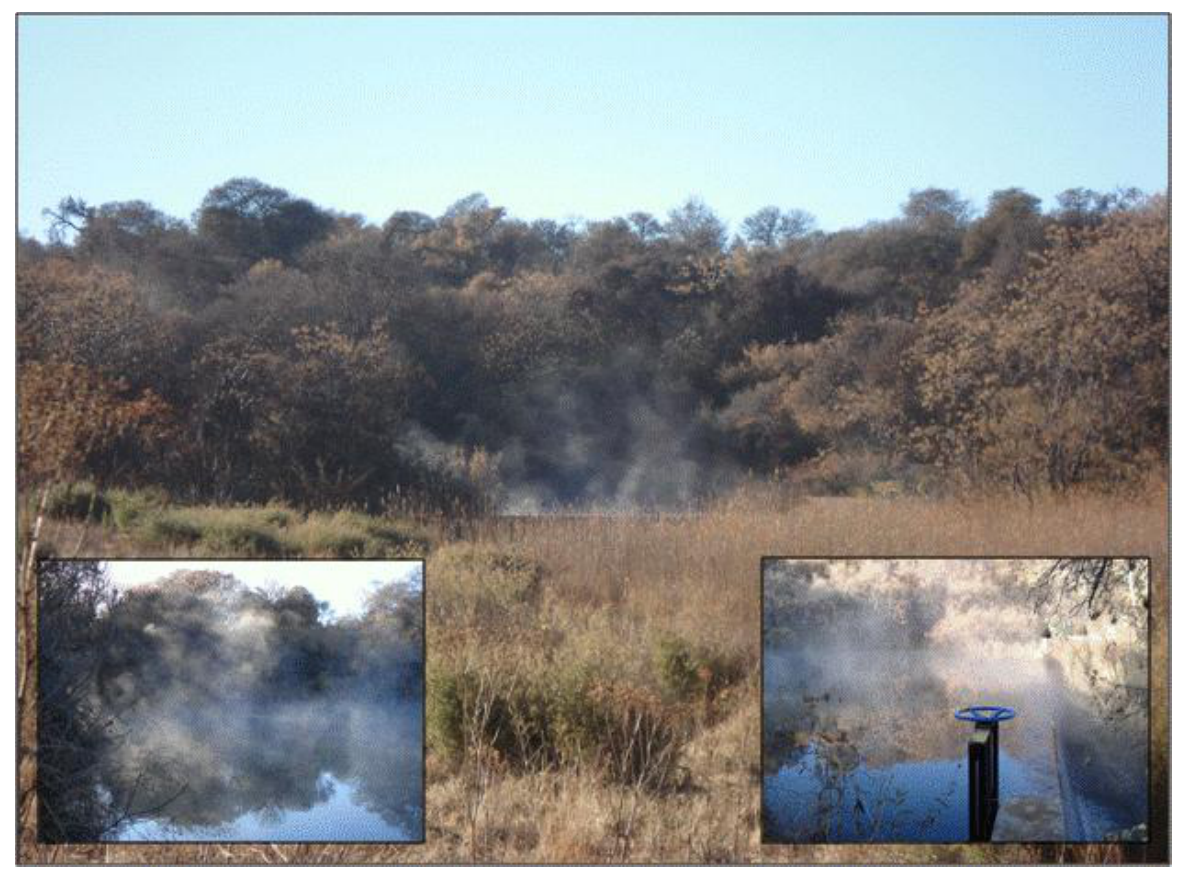
Figure 3. Steam emanating from the Gerhard Minnebron eye during a cold winter